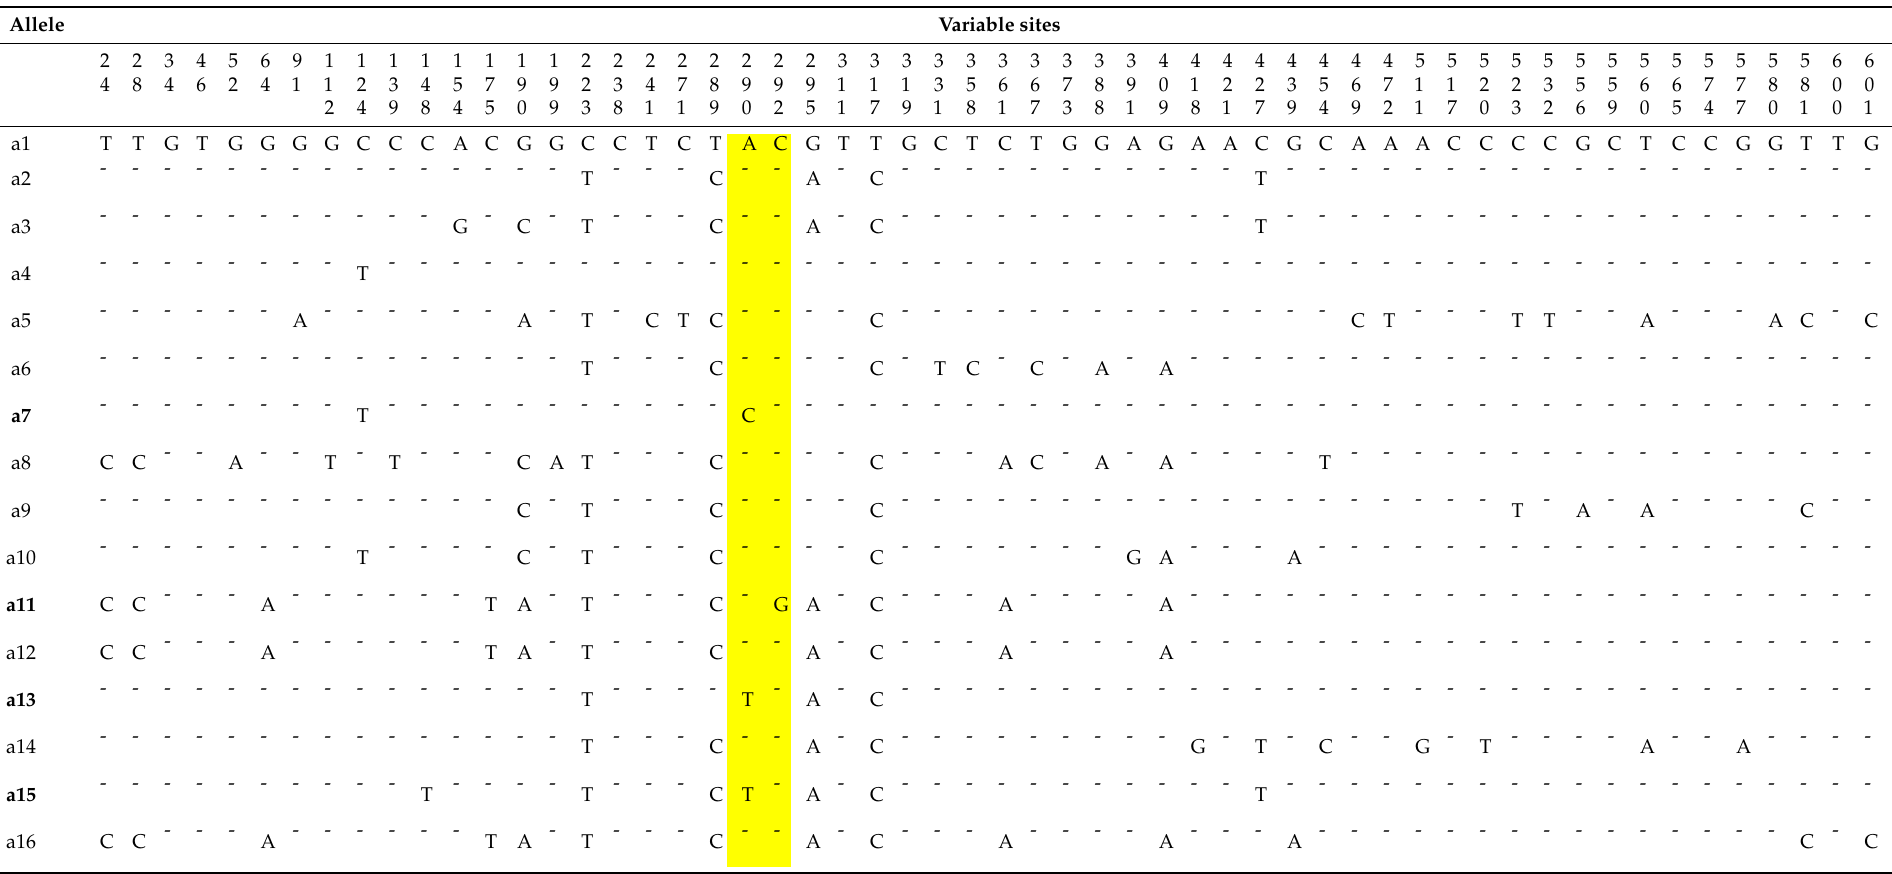
Table 2. Variable sites within the chs -1 alleles that carry the DFB-resistant mutations. Numbering starts from the first nucleotide of the 608 bp amplified sequence. In yellow, the DFB mutations in the codon I1043 (ATC) are shown: I1043L (CTC); I1043M (ATG); I1043F (TTC).